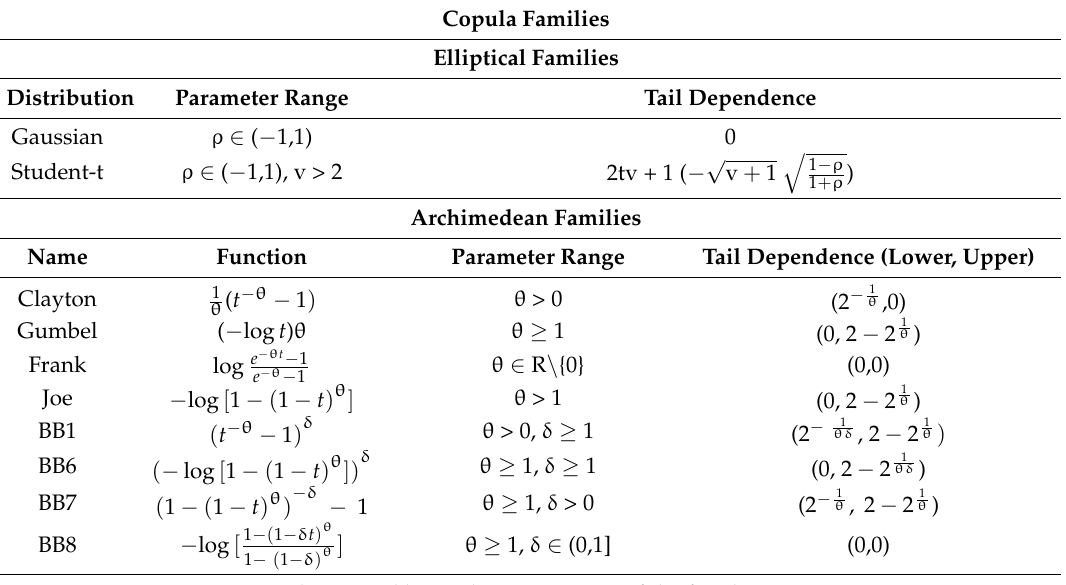
Table 1. Denotation and properties of Elliptical and Archimedean copula